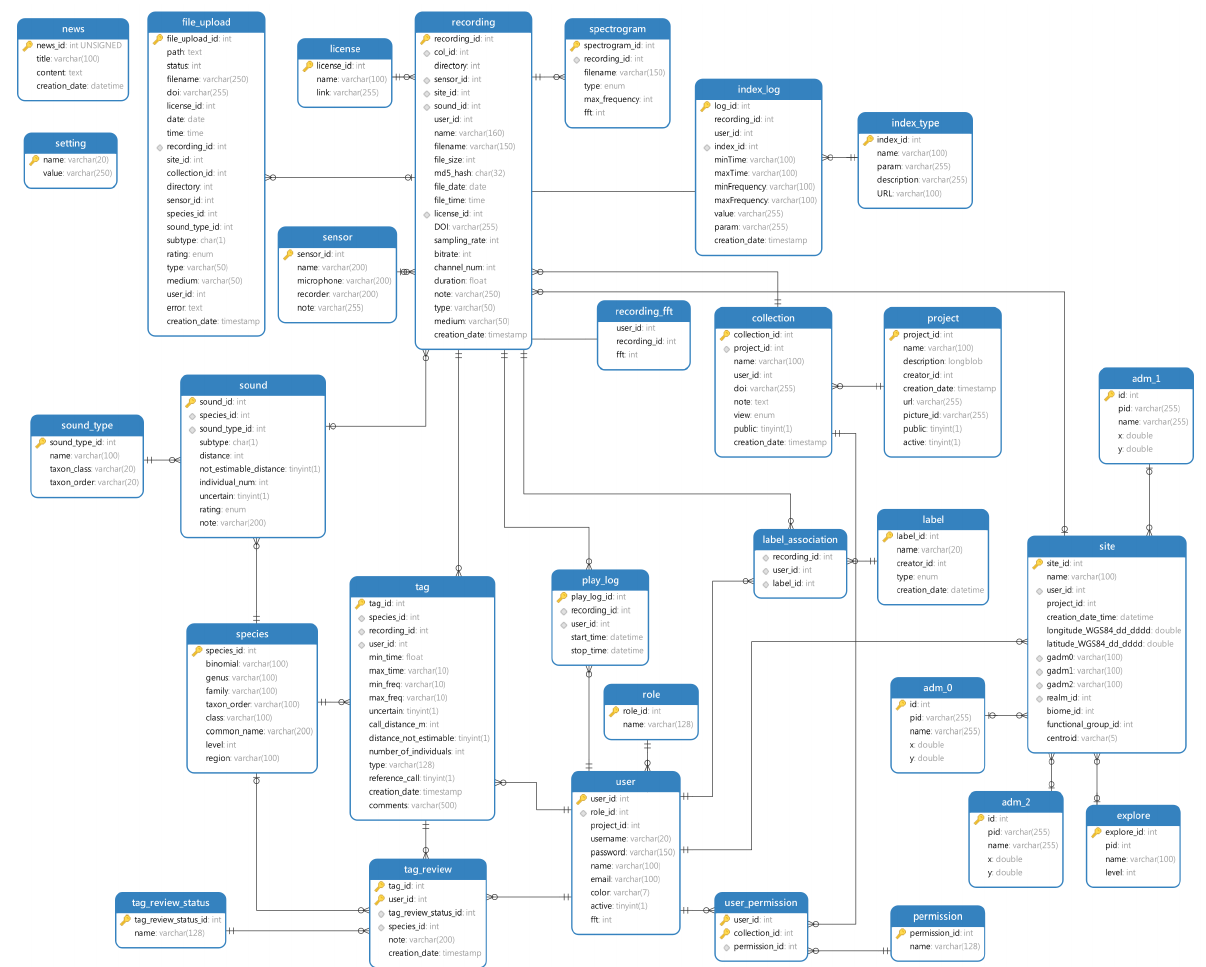
Figure 1. MySQL database structure in